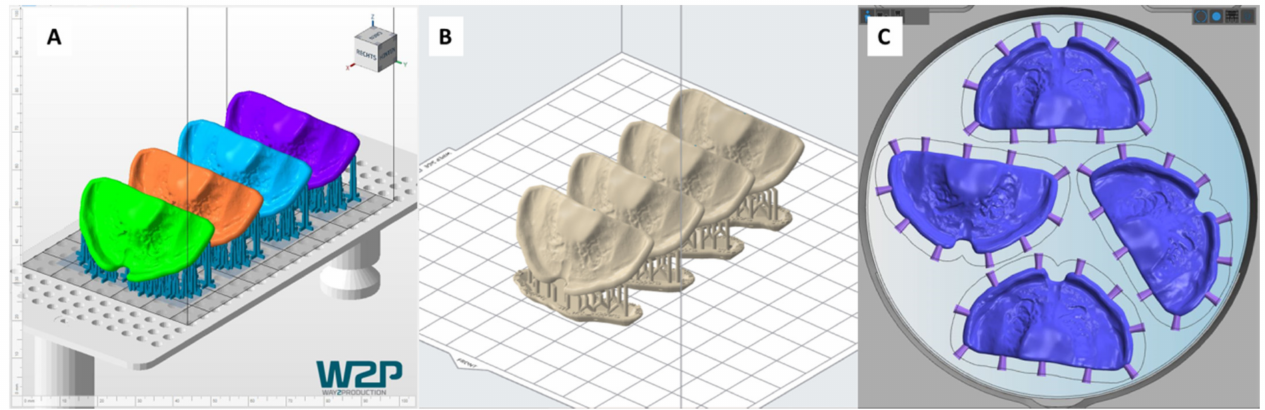
Figure 3. Sample positioning and supporting structures for the respective technology. ( A ) Positioning in Netfabb Premium 2019 for the Solflex 170 DLP device, ( B ) Positioning in Preform V3.01 for the Form 3B SLA device, ( C ) Positioning on DentalCAM for K5+ milling